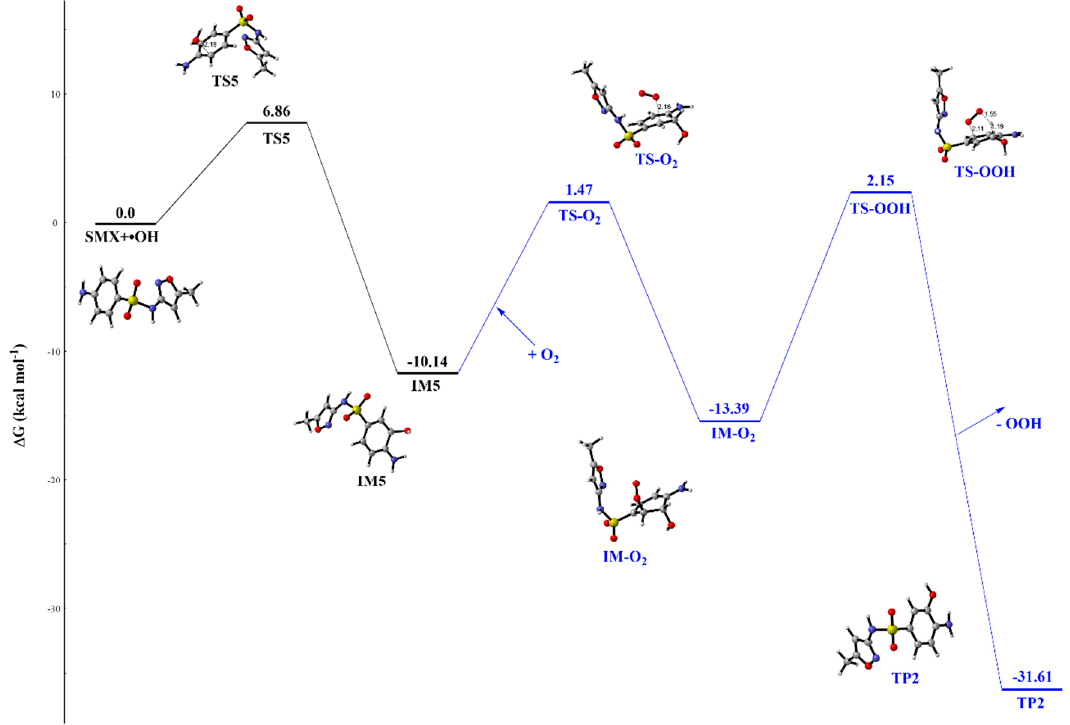
Figure 5. Schematic diagram of free energy for the subsequent reactions of IM5 during the Figure5. SchematicdiagramoffreeenergyforthesubsequentreactionsofIM5duringthetransformation transformation of SMX at the M06-2X/6–31 + G (d, p) level. of SMX at the M06-2X / 6–31 + G (d, p)